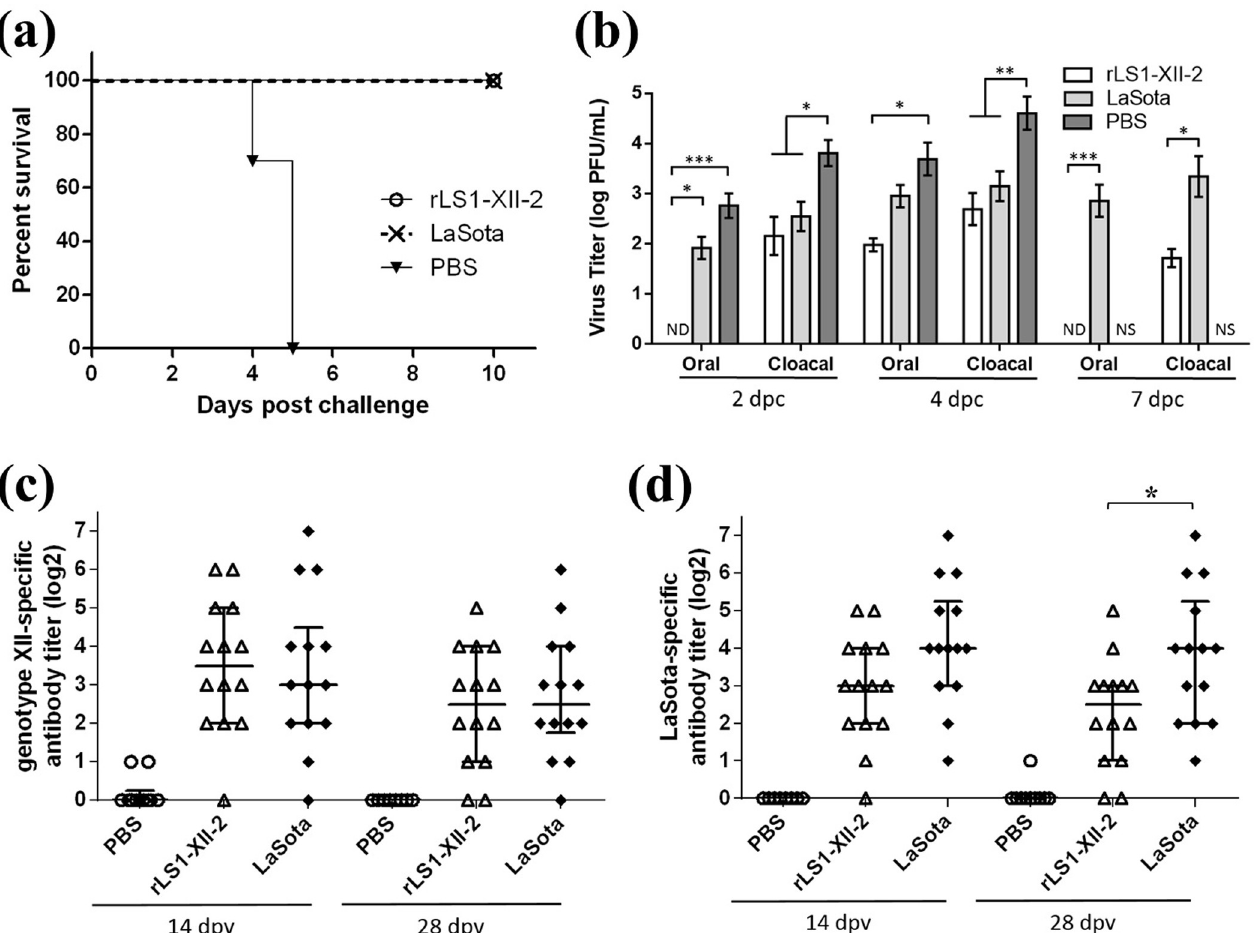
Fig 4. Comparison of the protection conferred by rLS1-XII-2 and LaSota strains against PP2011 (genotype XII) challenge. Chickens were immunized once at 7 days of age and the challenge performed 28 dpv with 10 5 LD 50 /bird via oculo-nasal route. (a) Survival rate of vaccinated chickens showed no mortality in 10 days following the challenge. (b) Viral shedding from oral and cloacal swabs from chickens that were positive to challenge virus isolation. (c and d) Genotypes XII- and II-specific neutralizing antibodies in vaccinated chickens at 14 and 28 dpv. Serum samples that were negative for neutralizing activity ( < 1:2 dilution) are shown as 0 values. � p < 0.05, �� p < 0.01 and ��� p < 0.001. ND = not detected; NS = no survivors.